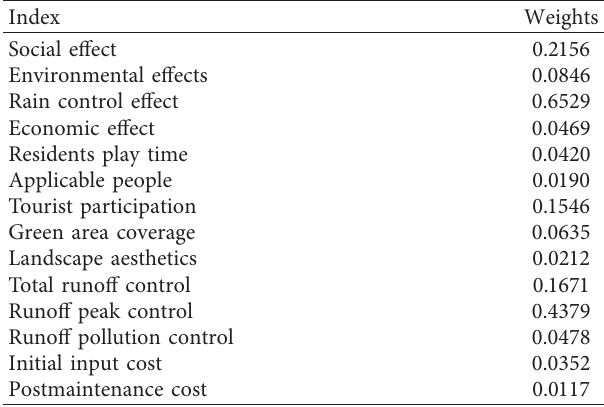
Table 14: The weight table of the effective plan of the pocket park rainwater system.